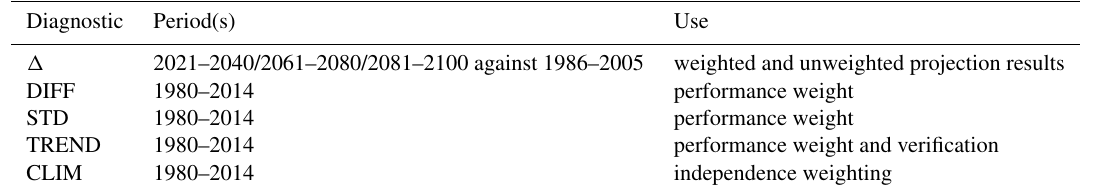
Table 2. Summary of each diagnostic’s use and time